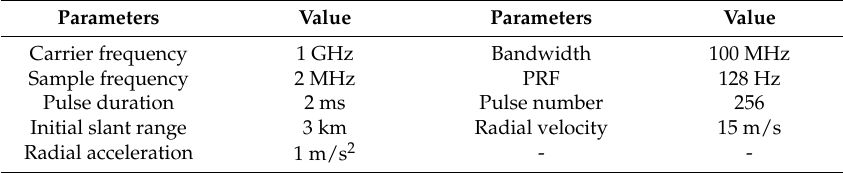
Table 2. Simulation parameters for the radar and target.